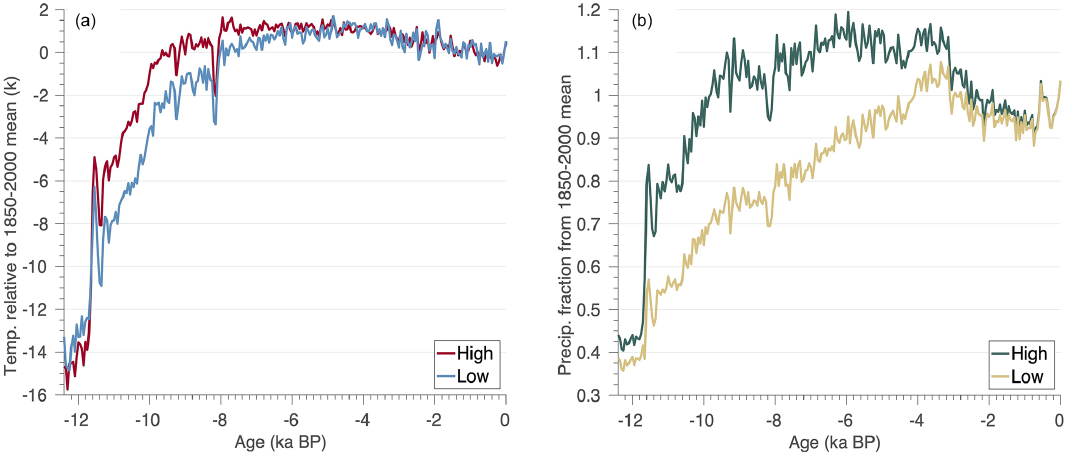
Figure 4. (a) Area-averaged (over model domain) mean annual temperature anomaly ( k ) relative to the 1850–2000 mean for the high- and low-temperature reconstructions from Badgeley et al. (2020). (b) Area-averaged (over model domain) mean annual precipitation as a fraction from the 1850–2000 mean for the high and low reconstructions from Badgeley et al. (2020). Table 1. Description of model experiments. See Fig. 4 for a display of the temperature and precipitation forcing scenarios. Temperature scenario Precipitation scenario Calving